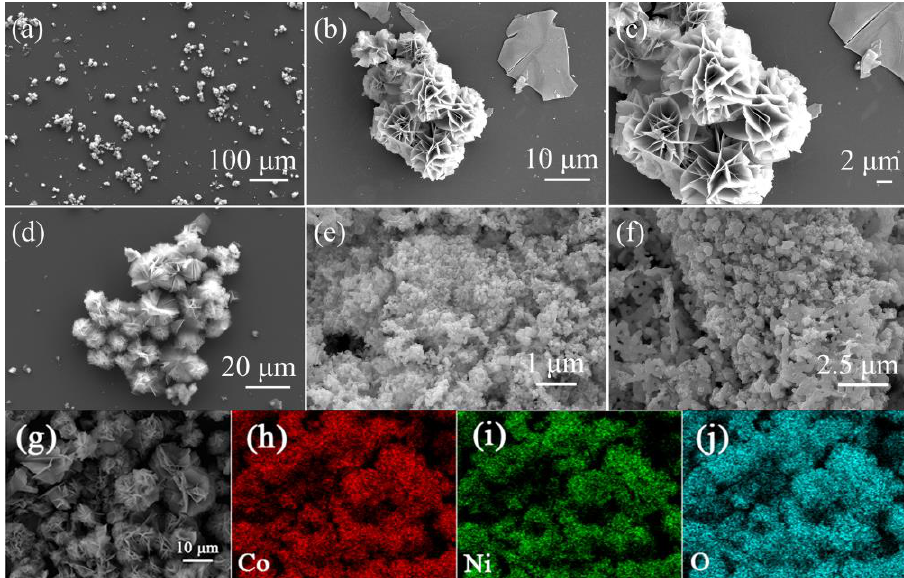
Figure 3. SEM images of ( a – d ) the hierarchical CoNiO 2 , ( e ) the metallic Ni and ( f ) the metallic Co. SEM picture of ( g ) CoNiO 2 and ( h – j ) the homologous elemental mapping pictures of Co, Ni and O for CoNiO 2 materials.